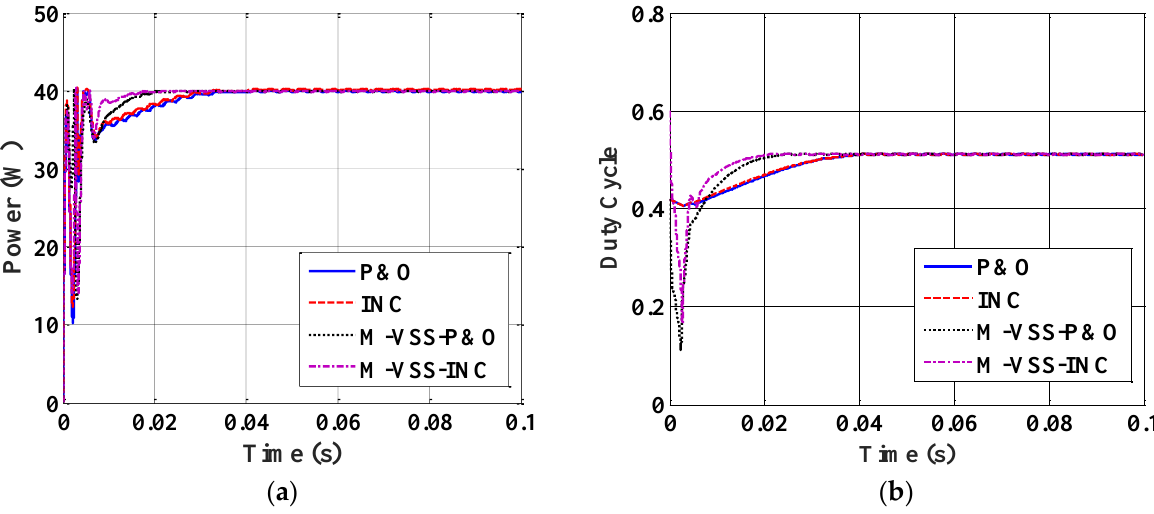
Figure 7. STC test of ST40 solar cell performance: ( a ) Output power and ( b ) duty cycle variation.